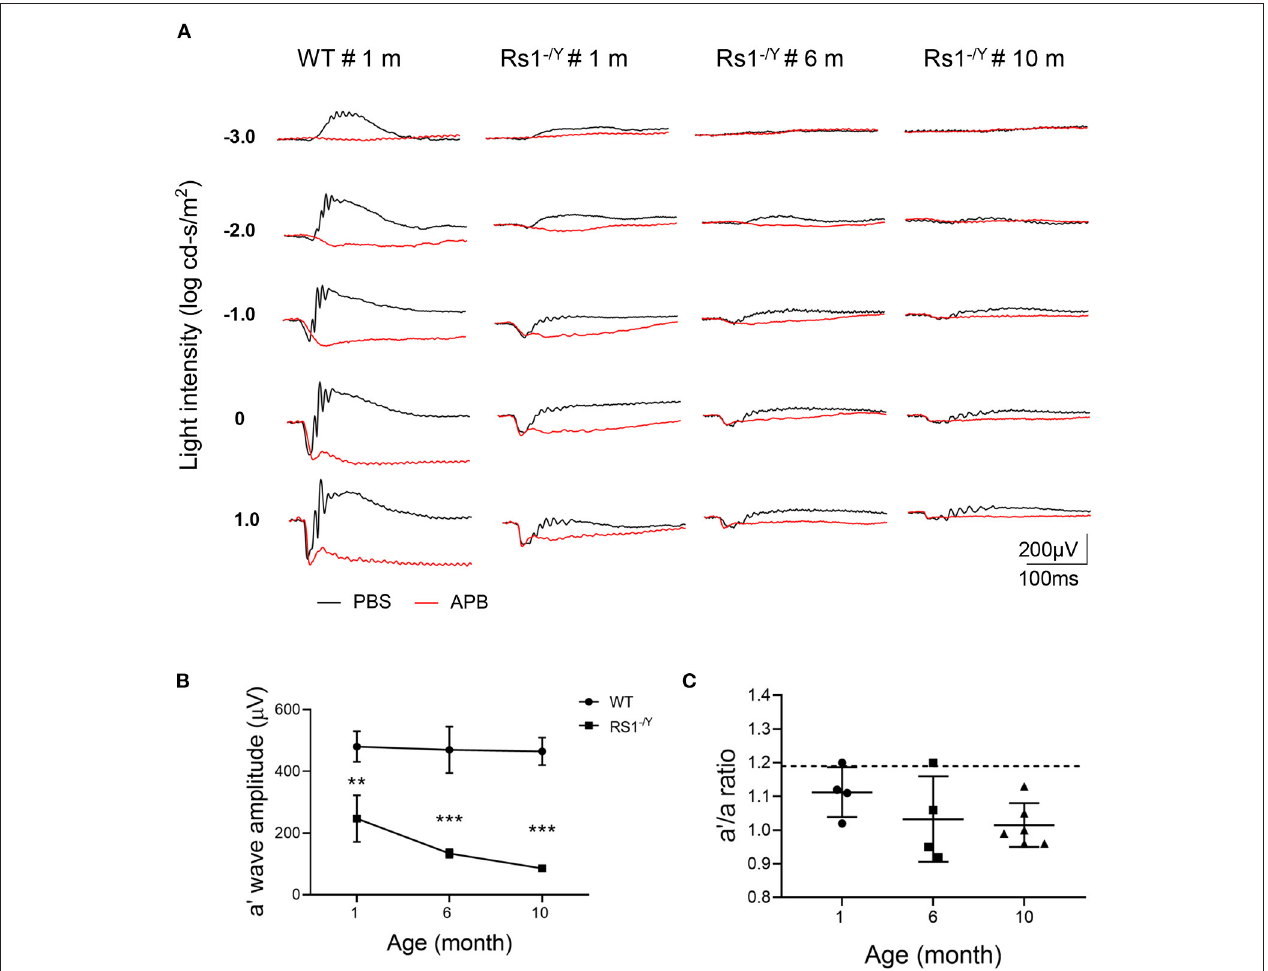
FIGURE 4 | The effect of APB on the dark-adapted ERG of Rs1 − / Y mice and and age-matched WT mice. (A) The black traces show ERGs of the PBS-injected control eyes and the red traces show ERGs of the APB injected eyes. In the APB-injected eye, the a-wave remains but the b-waves are absent. (B) Left: The a ′ wave amplitude changes with age in Rs1 − / Y mice of 1, 6, and 10 month old. ERG stimulus, 0 log cd-s/m 2 . (C) Right: a ′ /a ratio in Rs1 − / Y mice of three different ages (1, 6, and 10 months). Dashed lines: the a ′ /a ratio mean ± SE of WT: 1.190 ± 0.127 n = 5. a ′ wave: the negative wave in APB injected eye; APB, 2-amino-4-phosphobutyric acid. Rs1 − / Y results compared to WT using Student’s t-test: ***, P < 0.001.